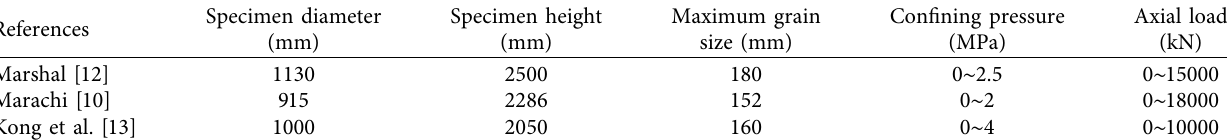
Table 1: Te super large apparatuses for rockfll triaxial